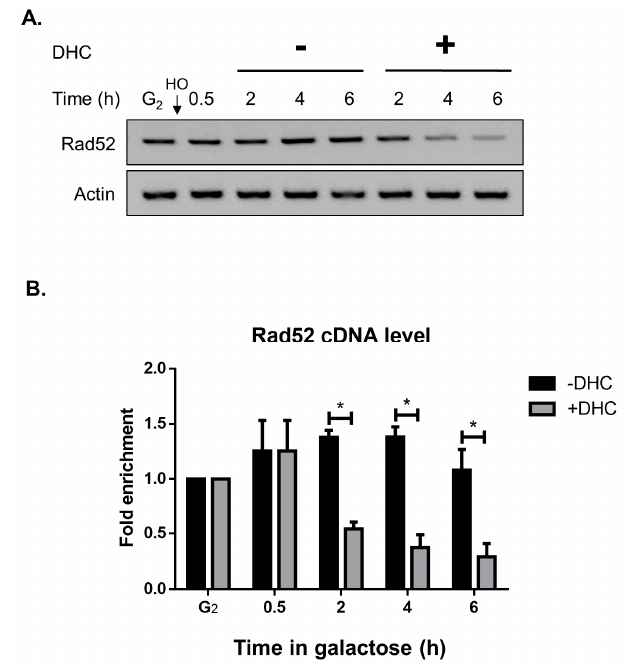
Figure 5. The cDNA levels of Rad52 are inhibited following DHC treatment. YMV045 cells were arrested at G2 with nocodazole, and HO endonuclease was induced by the addition of galactose to generate a DSB. After 30 min, the cultures were divided equally and treated with or without 5 mM DHC. Samples were processed for reverse transcription to generate cDNA and were analyzed by: ( A ) PCR; or ( B ) quantitative PCR. The error bars represent the standard deviations from three independent experiments. Asterisks (*) indicate significant differences between DHC-treated and untreated cells (* p < 0.05).